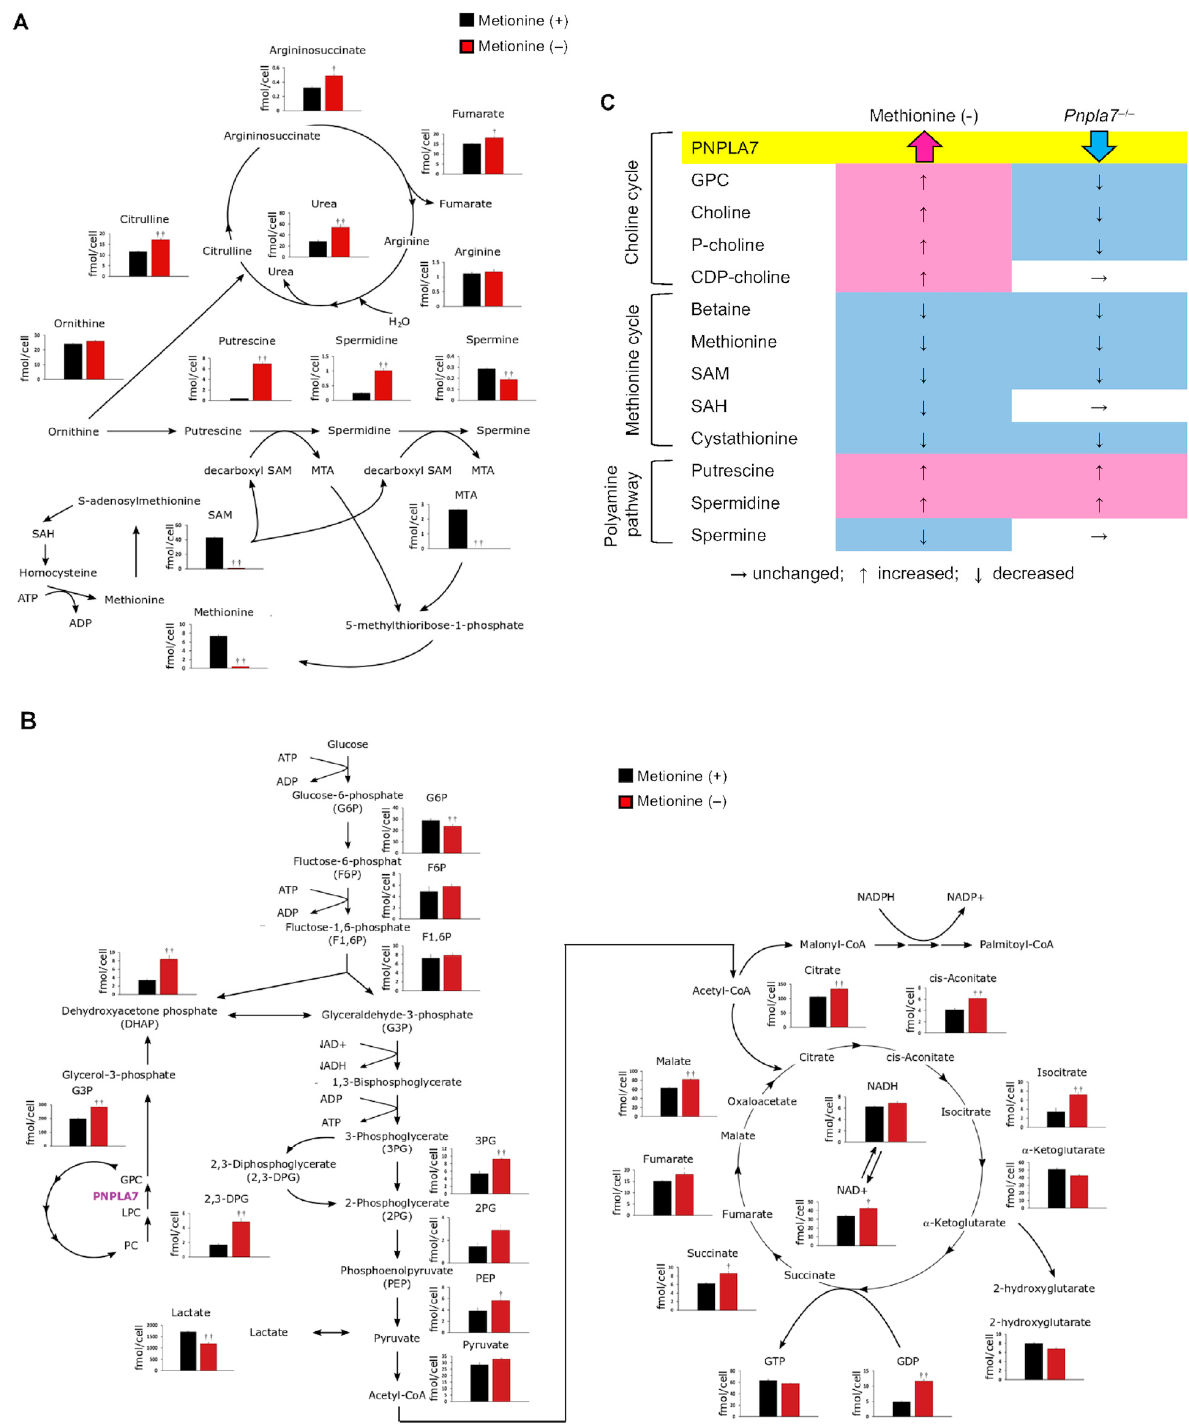
Figure 5. Effects of methionine deprivation on the urea cycle, polyamine synthesis, and methionine salvage pathway ( A ), and glycolysis and TCA cycle ( B ) in HepG2 cells. Graphs show the levels of individual metabolites in HepG2 cells cultured with (+) or without ( − ) methionine for 48 h. Quantification of each metabolite was performed by CE–MS. Mean ± SEM ( n = 4); †, p < 0.05; ††, p < 0.01; two-tailed Student’s t -test. ( C ) Comparison of the changes in various metabolites in methionine-deprived HepG2 cells with those in the liver of Pnpla7 − / − mice [14]. In methionine-deprived HepG2 cells, the levels of metabolites in the choline cycle were increased because of the upregulation of PNPLA7, whereas in Pnpla7 − / − liver the absence of PNPLA7 decreased their levels. In both cases, the methionine flux decreased, resulting in similar alterations in multiple metabolites in the methionine cycle and the polyamine pathway. For details, please see the text.